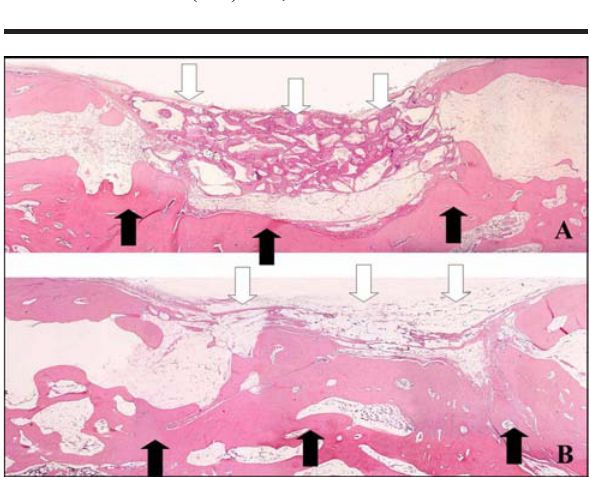
FIGURE 4 - Photomicrograph of a defect of Group A (A) and of Group B (B) at 90 days after surgery. The neoformed bone areas are indicated by black arrows and the graft biomaterial by the white arrows. HE,